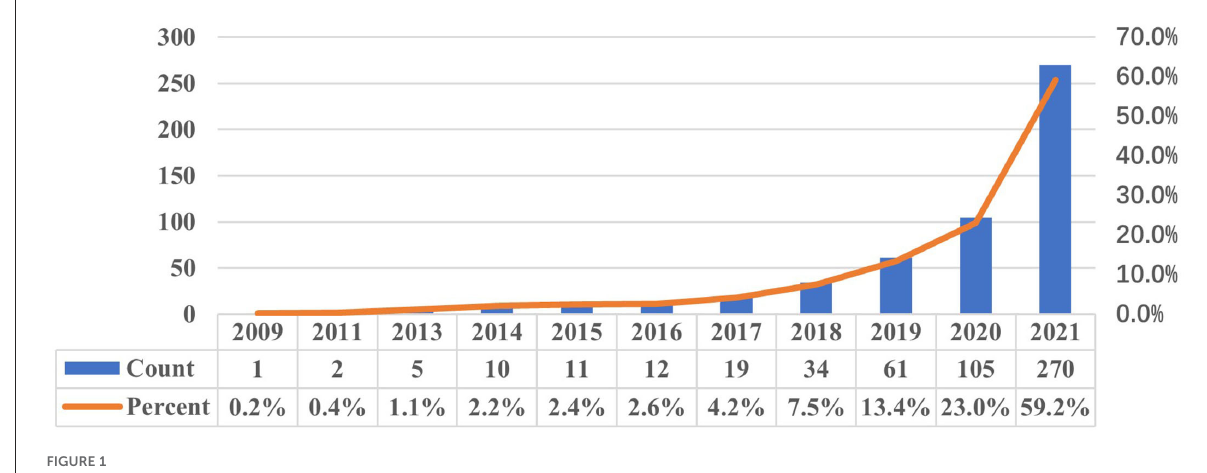
FIGURE1 The number of publications per year